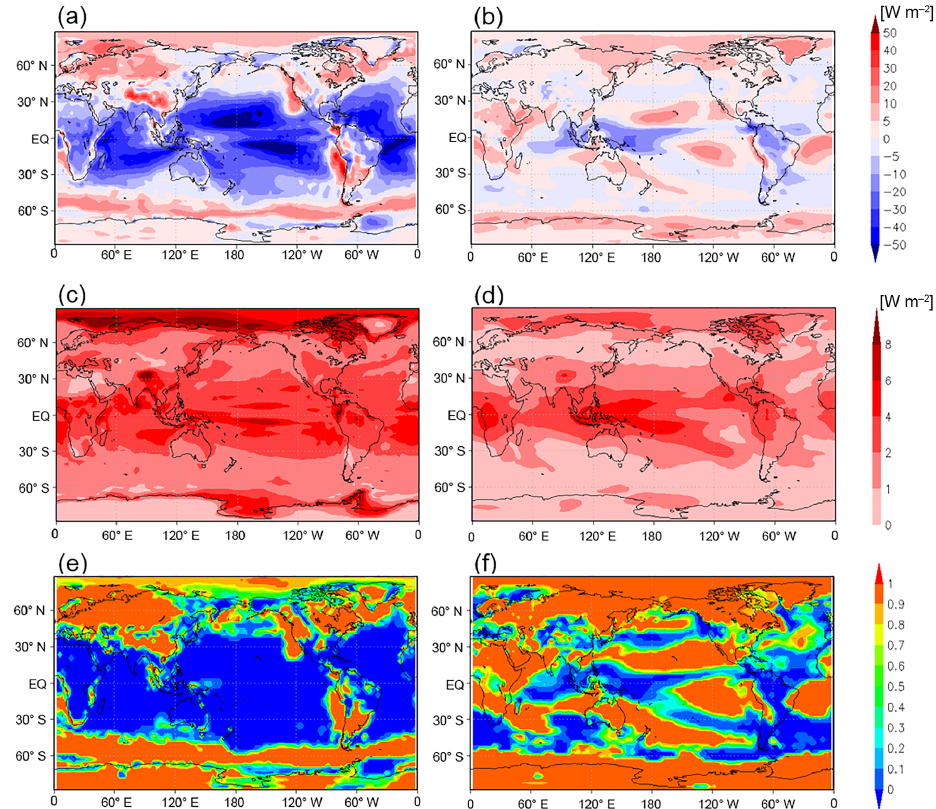
Figure 3. TOA radiation bias in the annual mean for the (a) shortwave CRE and (b) longwave CRE components. The biases are for the ensemble mean of the MIROC5 PPE with respect to CERES-EBAF. Standard deviation of the TOA radiation bias among the PPE ensemble members for the (c) shortwave CRE and (d) longwave CRE. Fraction of the PPE ensemble members, which have positive signs of the TOA radiation bias, for the (e) shortwave CRE and (f) longwave